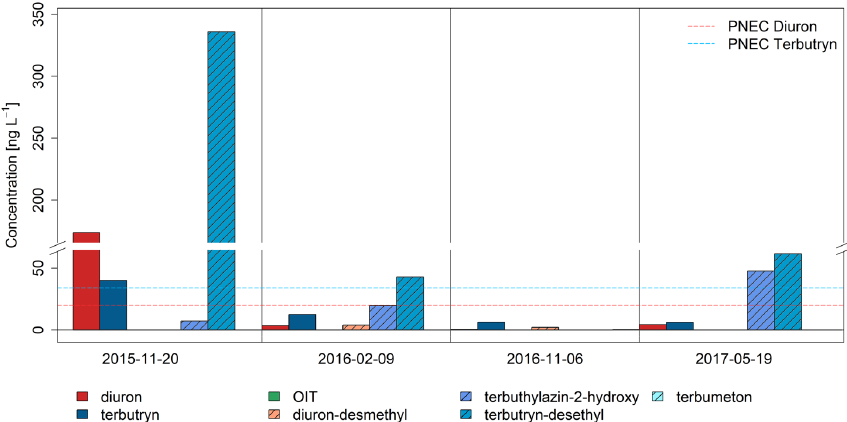
Figure 5. Concentrations of monitored biocides of standing water in the swale during four events.